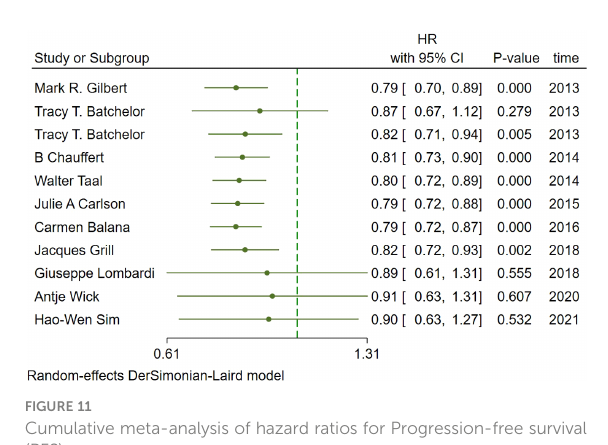
FIGURE 11 Cumulative meta-analysis of hazard ratios for Progression-free survival